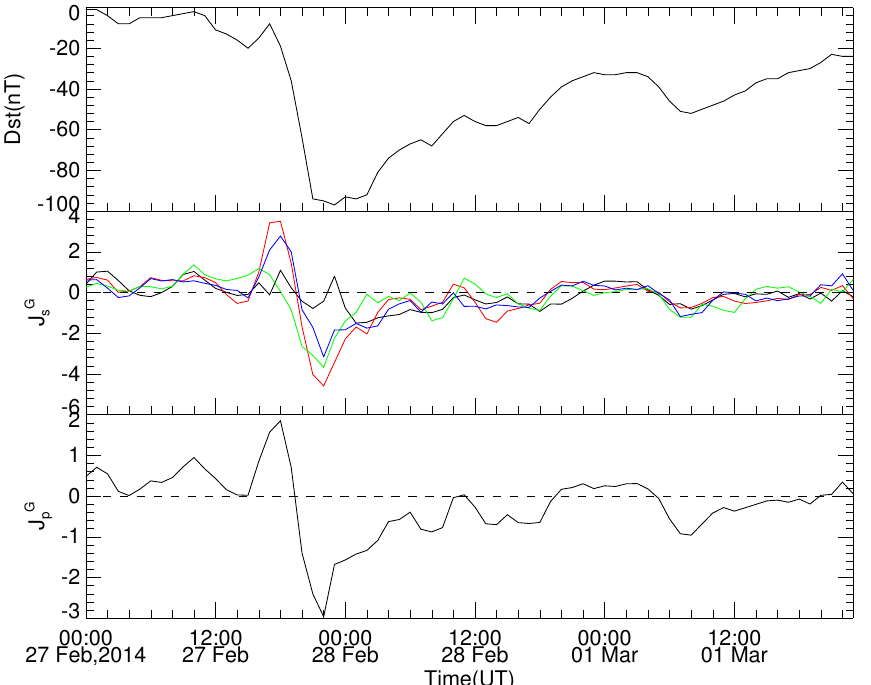
Figure 1. Comparation of the Dst index and our new index during the magnetic storm from 27 February to 1 March 2014. The top panel shows the Dst index. The middle panel shows the single– station geomagnetic disturbance index J G s for HER (green), KAK (black), HON (blue), and SJG (red) stations. The bottom panel shows the global geomagnetic disturbance index J G p